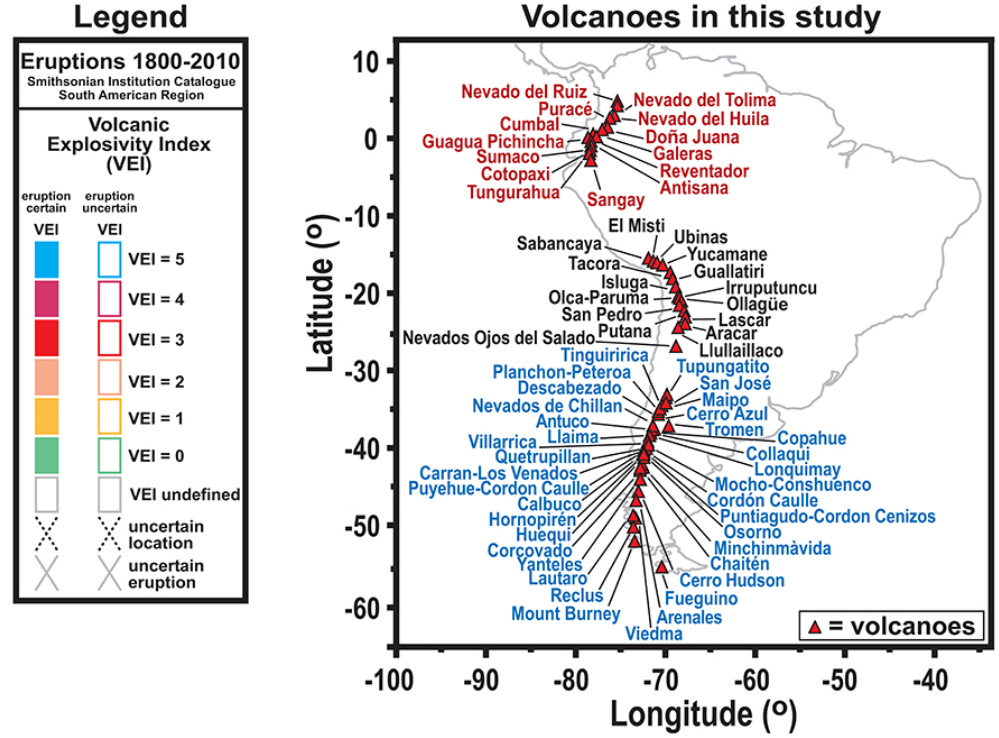
Fig. 1b. Legend and Map of South American Volcanoes relative to the complete catalogue of eruption data for the Andean belt from 1800 to 2010 represented in Fig. 1a. The coloured names of the volcanoes are subdivided according to the three volcanic districts (northern-red, central-black,